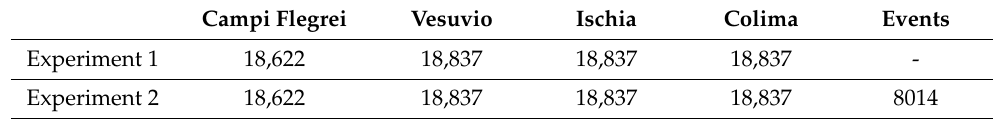
Table 2. Experiment setting: class sizes associated with each background noise source. Campi